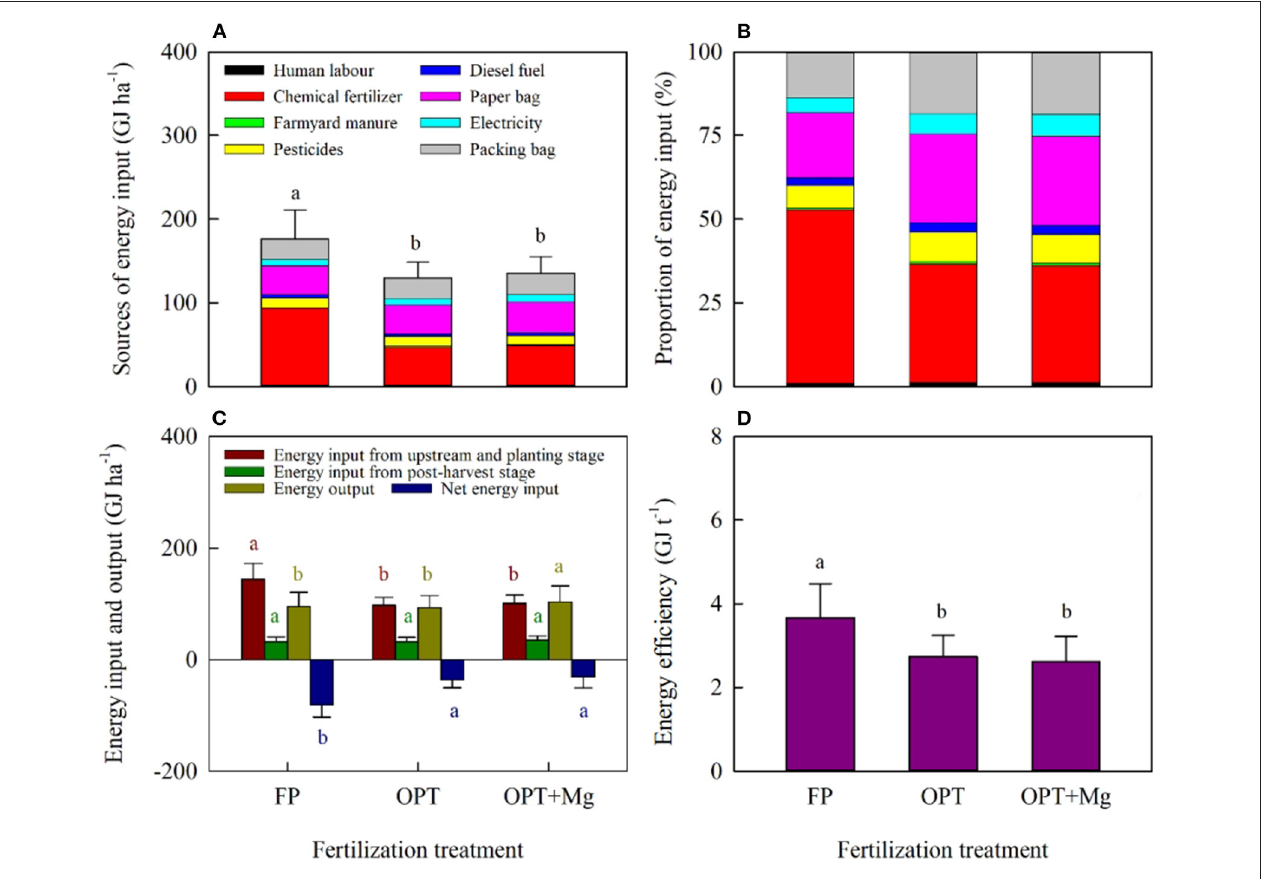
FIGURE 4 | Different sources (A) and proportions (B) of energy input, energy input and output (C) , and energy efficiency (D) under different fertilization treatments in pomelo production. The black error bars in the figure indicate the standard deviation (SDs). Different letters above histogram bars with the same color indicate statistically significant differences at P <